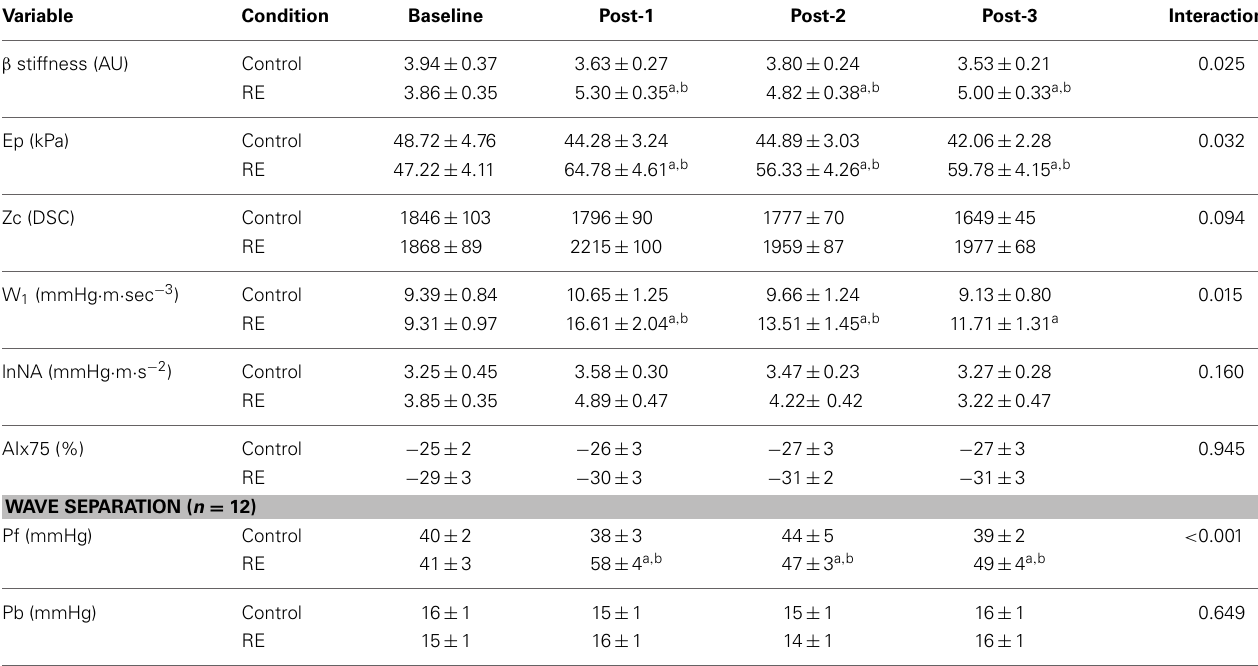
a Significantly different from within-condition BL, p < 0.05. b Significantly different from other condition, same time point, p < 0.05.